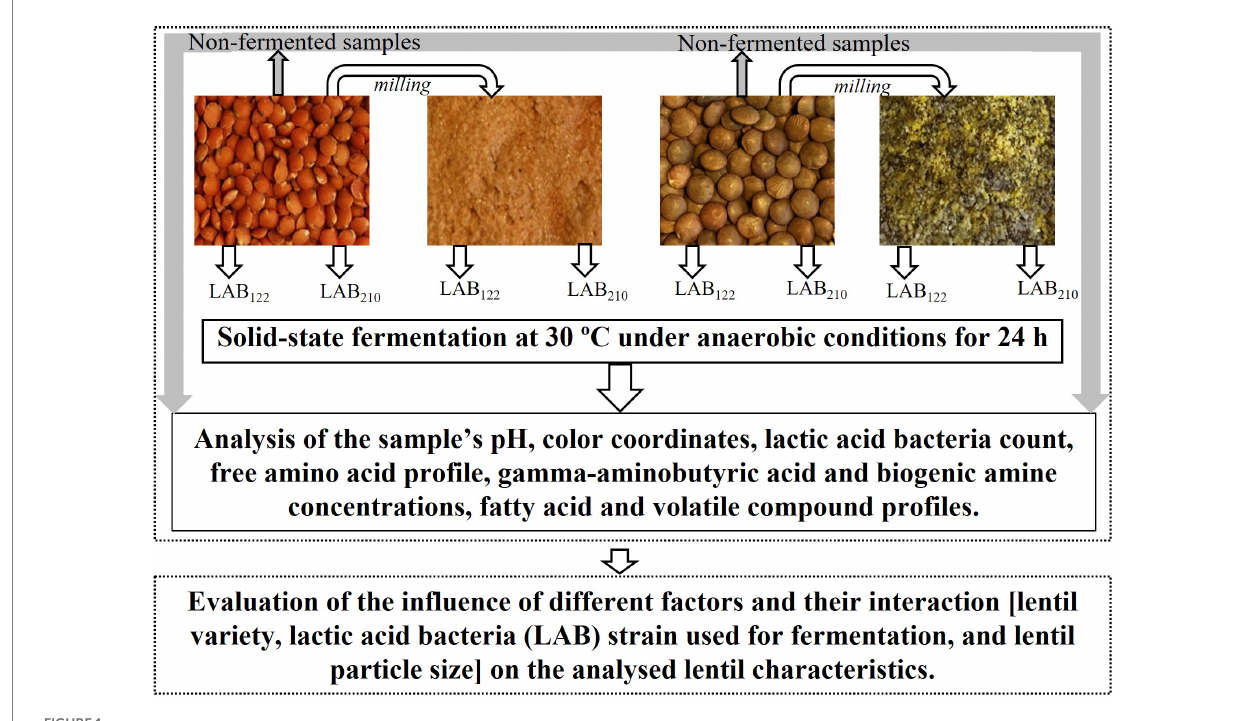
FIGURE 1 Experimental design (LAB—lactic acid bacteria strain; 122 — Lactiplantibacillus plantarum strain; 210 — Lacticaseibacillus casei